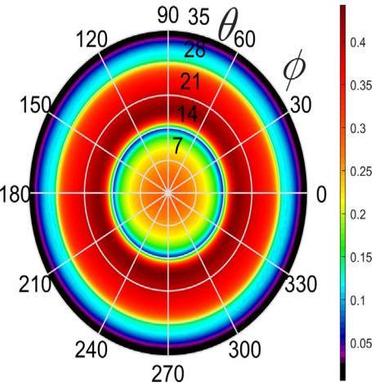
Experimentally obtained amplitude P-UPS plot for an aluminum plate of thickness d = ± 1.500 0.002 mm and density ρ = 2700 kg/m3. Note the circular patterns suggesting an isotropic symmetry.